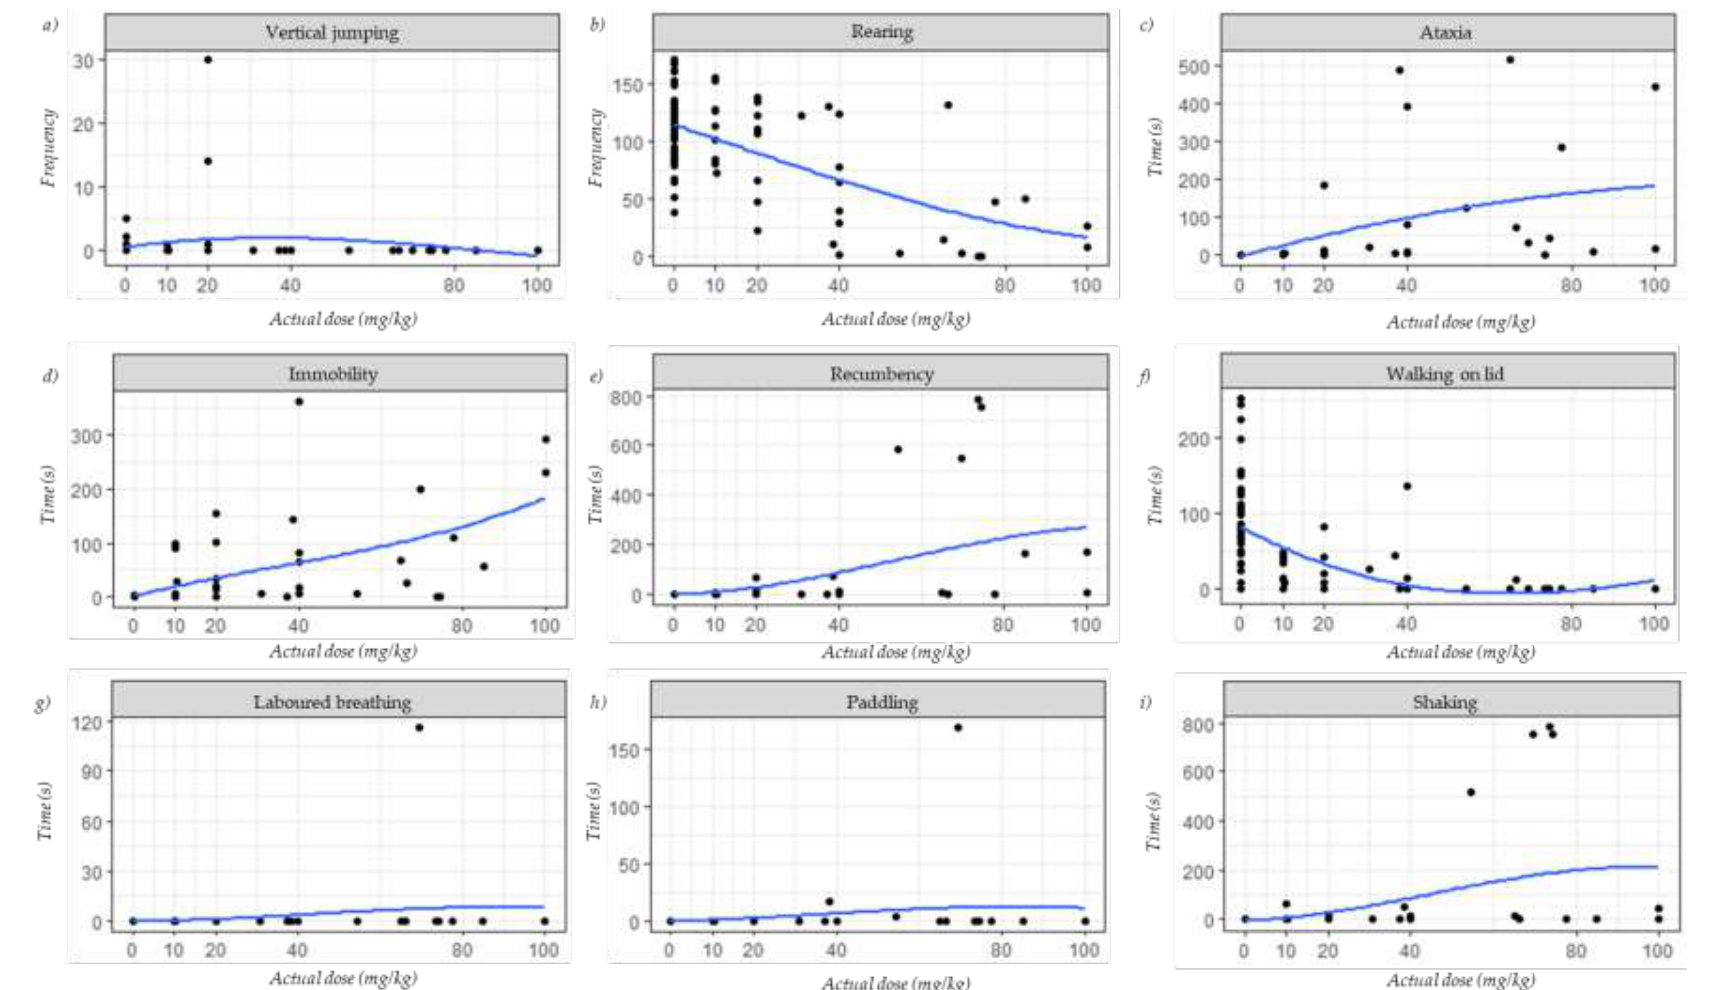
Figure 1. Behaviours reported for the first 800 s of the sedation period presented according to the actual doses of tiletamine-zolazepam in C57BL/6 mice: ( a ) vertical jumping; ( b ) rearing; ( c ) ataxia; ( d ) immobility; ( e ) recumbency; ( f ) walking on lid; ( g ) laboured breathing; ( h ) paddling; ( i ) shaking. Each point represents a single mouse. Blue trend lines are locally weighted smoothing (loess) lines.